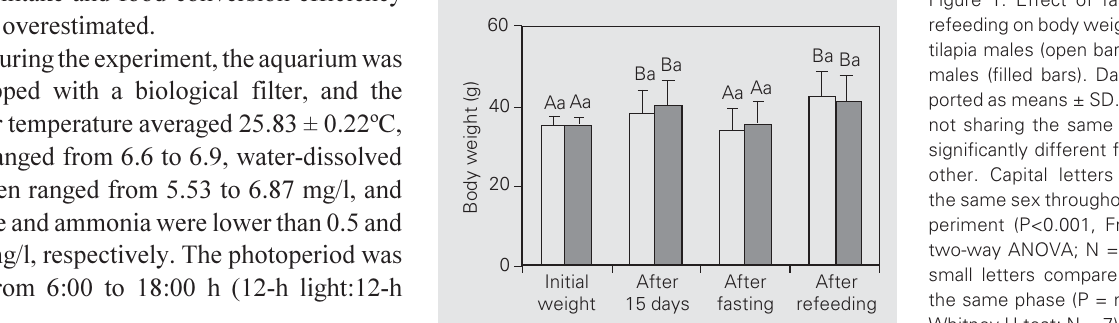
Figure 1. Effect of fasting and refeeding on body weight of Nile tilapia males (open bars) and fe- males (filled bars). Data are re- ported as means ± SD.